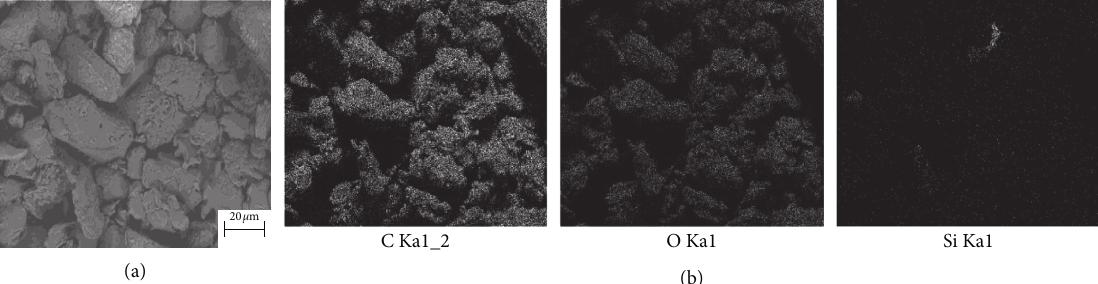
Figure 1: (a) SEM micrographs of the walnut shell powder without treating with the silica sol (500 × ). (b) Surface element analysis of untreated walnut shell